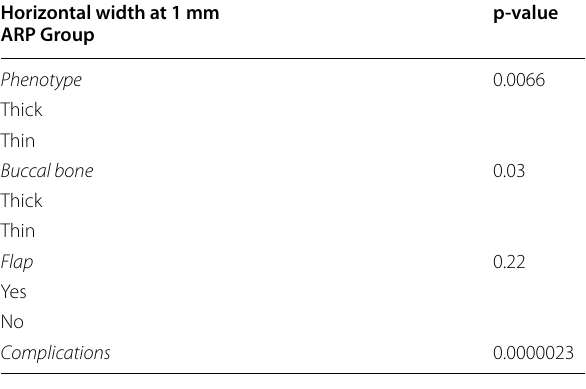
Table 3 Summary of the variables considered for t test for independent samples in ARP group